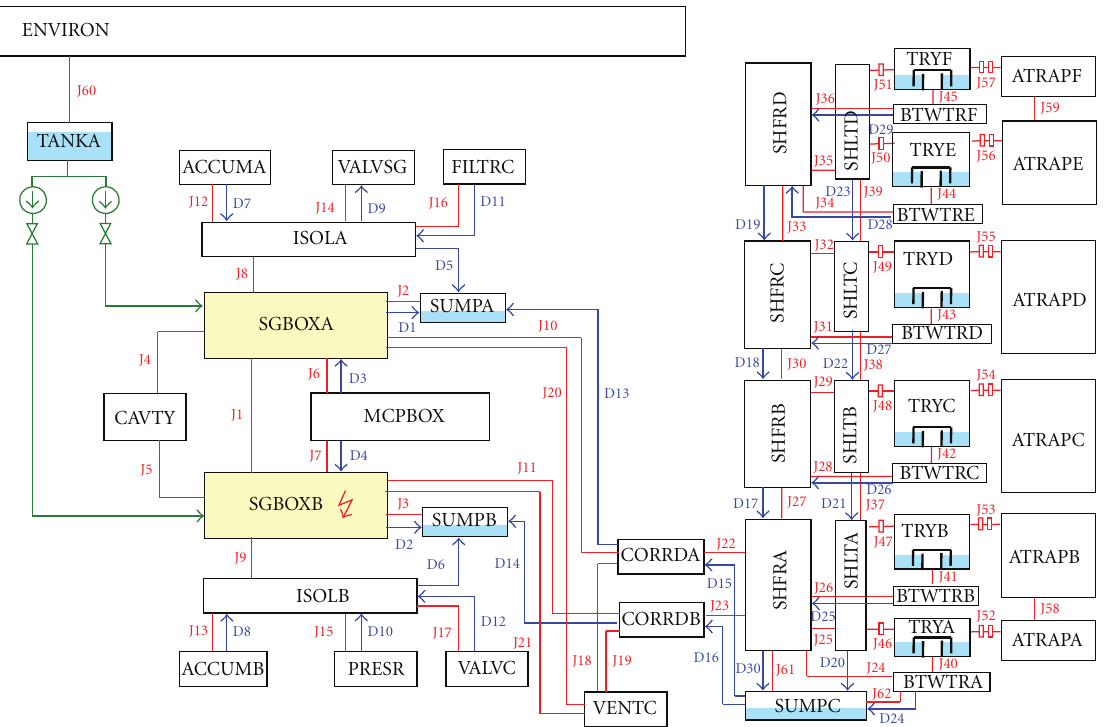
Figure 14: Nodalization scheme of Kola NPP unit 3 Bubble Condenser